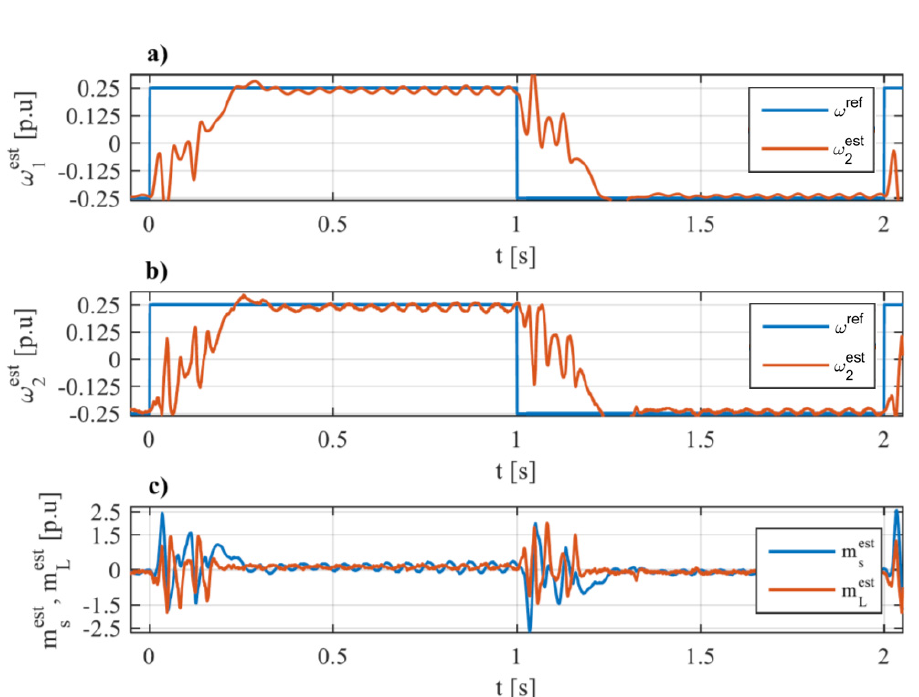
Figure 6. The results of a HIL simulation with Luenberger observer: ( a ) Drive motor speed, ( b ) load speed, ( c ) torsional and load torque.